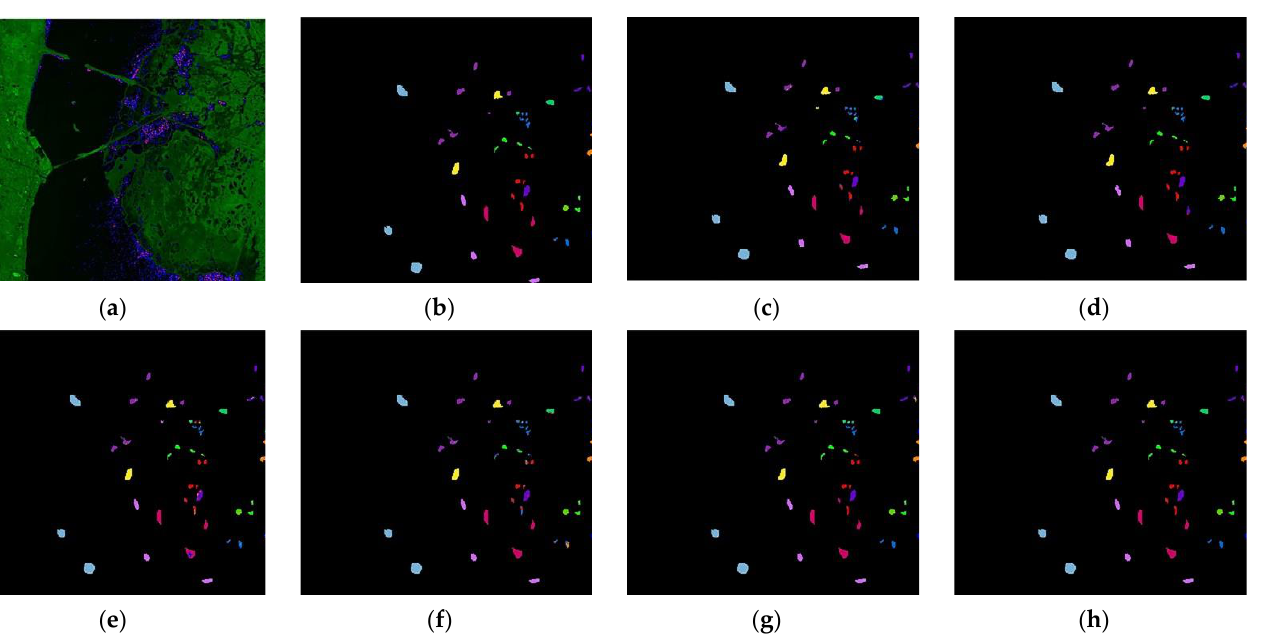
Bold numbers indicate the best performance.